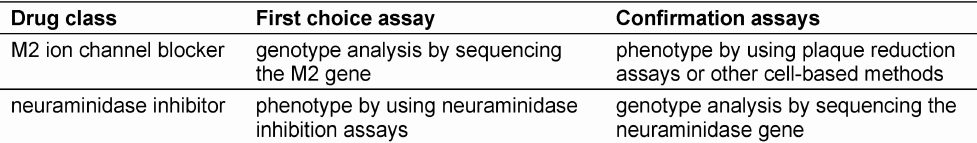
Table 2: Influenza antiviral resistance